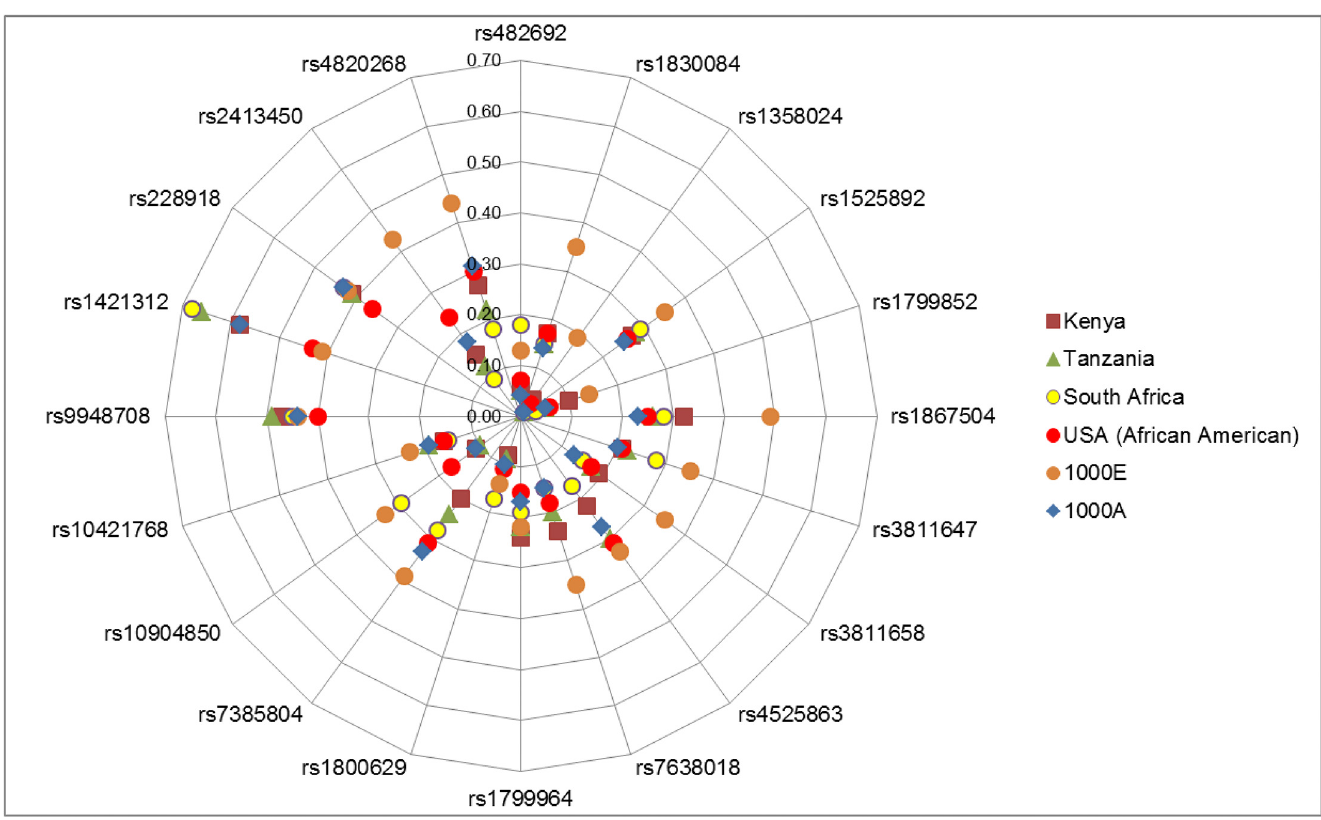
Fig 1. Minor allele frequency of common genetic variants related to iron metabolism in four African ancestry populations in comparison to the African and European population in the 1000 Genomes Project database. MAF 1000 A, Minor allele frequency for Africans-1000 Genomes Project; MAF 1000 E, Minor allele frequency for Europeans- 1000 Genomes